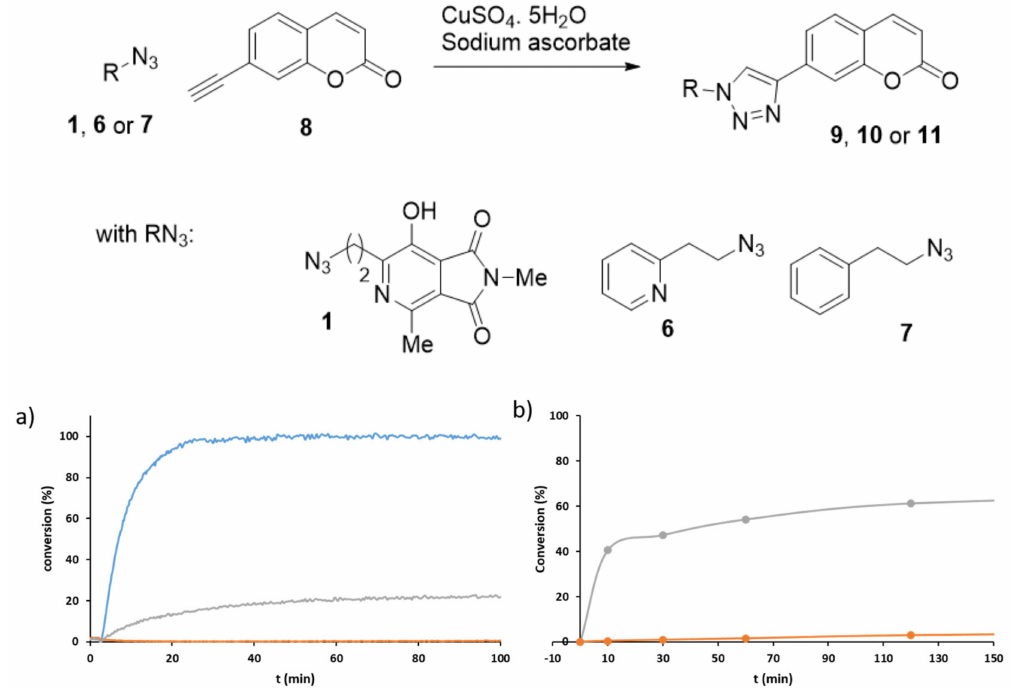
Figure 3. Comparison of kinetics of CuAAC reactions of: ( a ) 7-ethynyl coumarin (17.5 µ M), with azide ( 1 in grey, 6 in blue, and 7 in orange) in the presence of CuSO 4 · 5H 2 0 (17.5 µ M) and sodium ascorbate (437 µ M) in DMF:PBS pH 7.4:H 2 O (1:1:2); ( b ) 7-ethynyl coumarin (175 µ M), with azide ( 1 in grey, and 7 in orange) in the presence of CuSO 4 .5H 2 O (175 µ M) and sodium ascorbate (4.375 µ M) in DMF:PBS pH 7.4:H 2 O